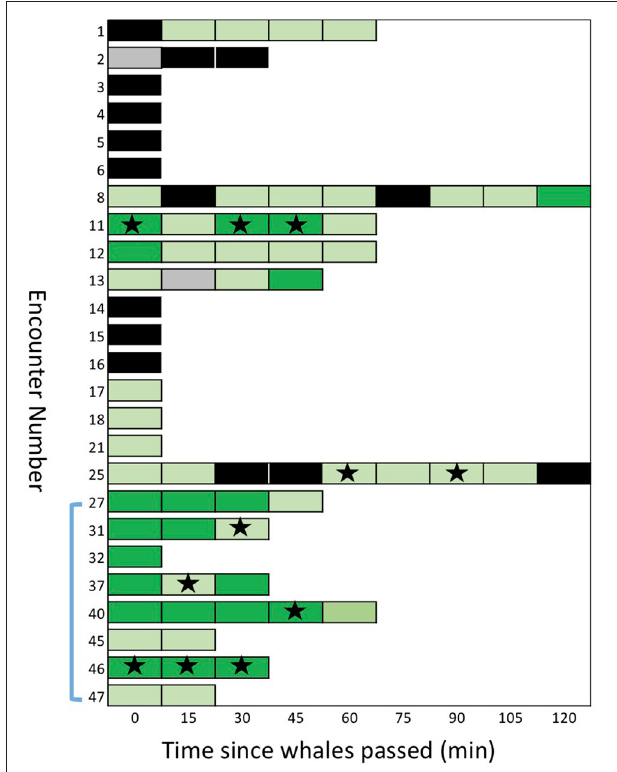
FIGURE 5 | A sequential stack plot of the number of samples (for each of the 25 encounters) judged to be positive or negative for detection of eDNA under two different thresholds. Each block in the stack represents a sample: dark green are samples with an average of > 0.5 copies/ µ l (strict detection); light green are greater than the maximum of the negative controls, > 0.12 copies/ µ l, but < 0.5 copies/ µ l (relaxed detection). Samples shown in black are considered “no detection,” with < 0.12 copies/ µ l. Samples in gray are missing data. Stars indicate samples that provided mtDNA sequences after amplification of eDNA or re-amplification from ddPCR reactions. The blue bracket indicates the encounters during which samples were collected from the air/surface